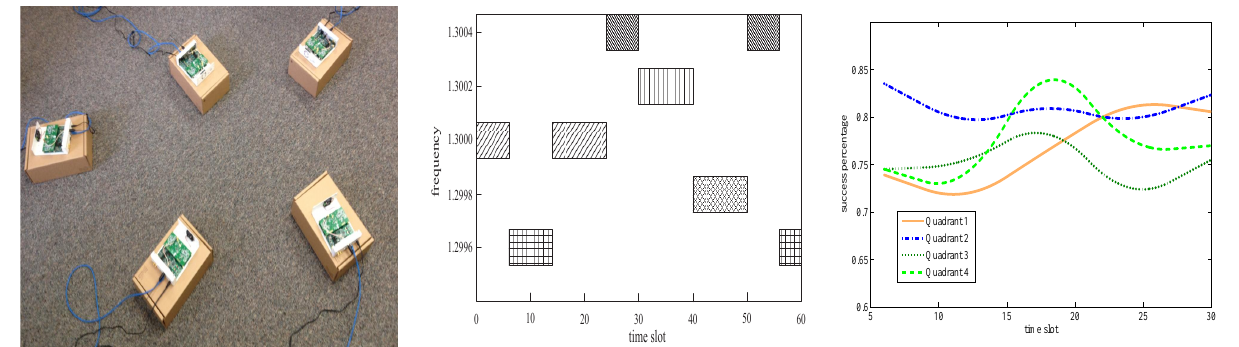
Figure 8. Experiment view Figure 9. A pattern of the primary user Figure 10. Results from four quadrants.